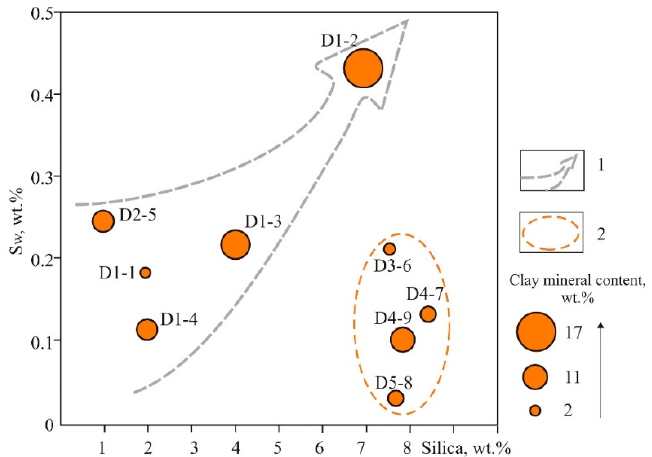
Figure 7. Primary water saturation Sw versus silica content plot (size of circles shows clay minerals content). The typical correlation between water saturation and main minerals content is demonstrated by samples D1-2, D1-3, and D1-4 (arrow) (1). Organic-rich samples fall within a single separate field (2) with high silica content.